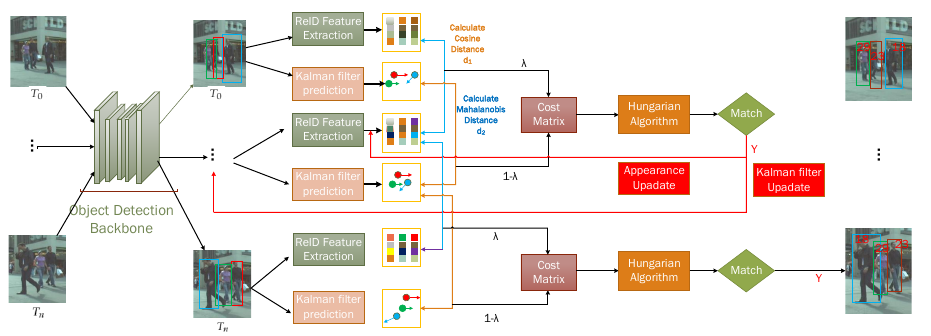
Figure 3. The architecture picture of our approach, T 0 represents the initial frame, T n represents the current frame, and λ is a hyperparameter for calculating the cost matrix. Bounding boxes and identities are marked in the frames. Bounding boxes with different colors represent different